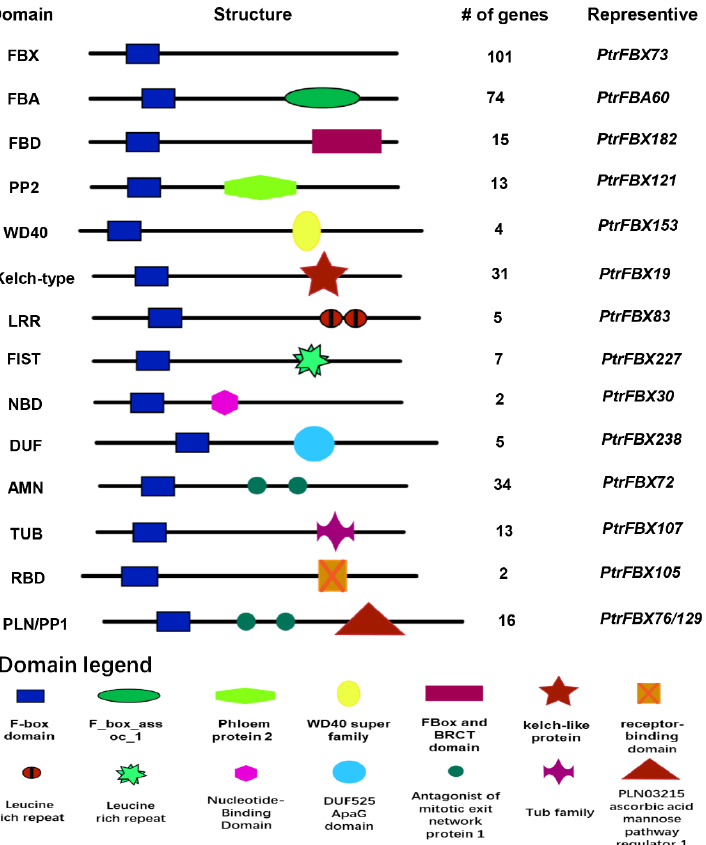
Figure 1. A map of P. trichocarpa canonical F-box proteins with structural and positional information of the C-terminal interacting domains; shown on the left is the type of the C-terminal domain and on the right are the number and representative genes predicted to contain F-box proteins of these domains. Below are the comments for each structure field.